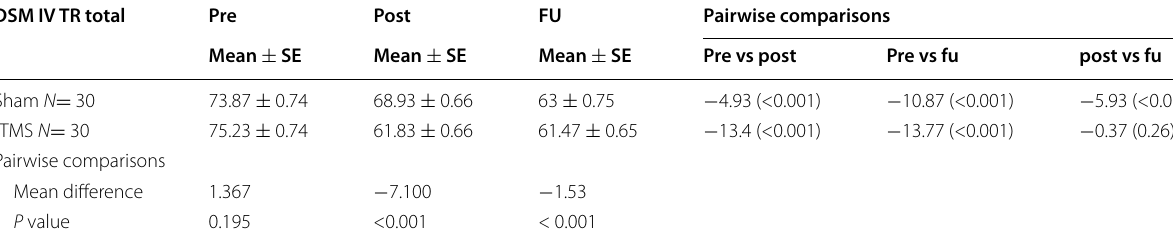
Table 4 Comparing mean total DSM IV T score between the 2 groups at different